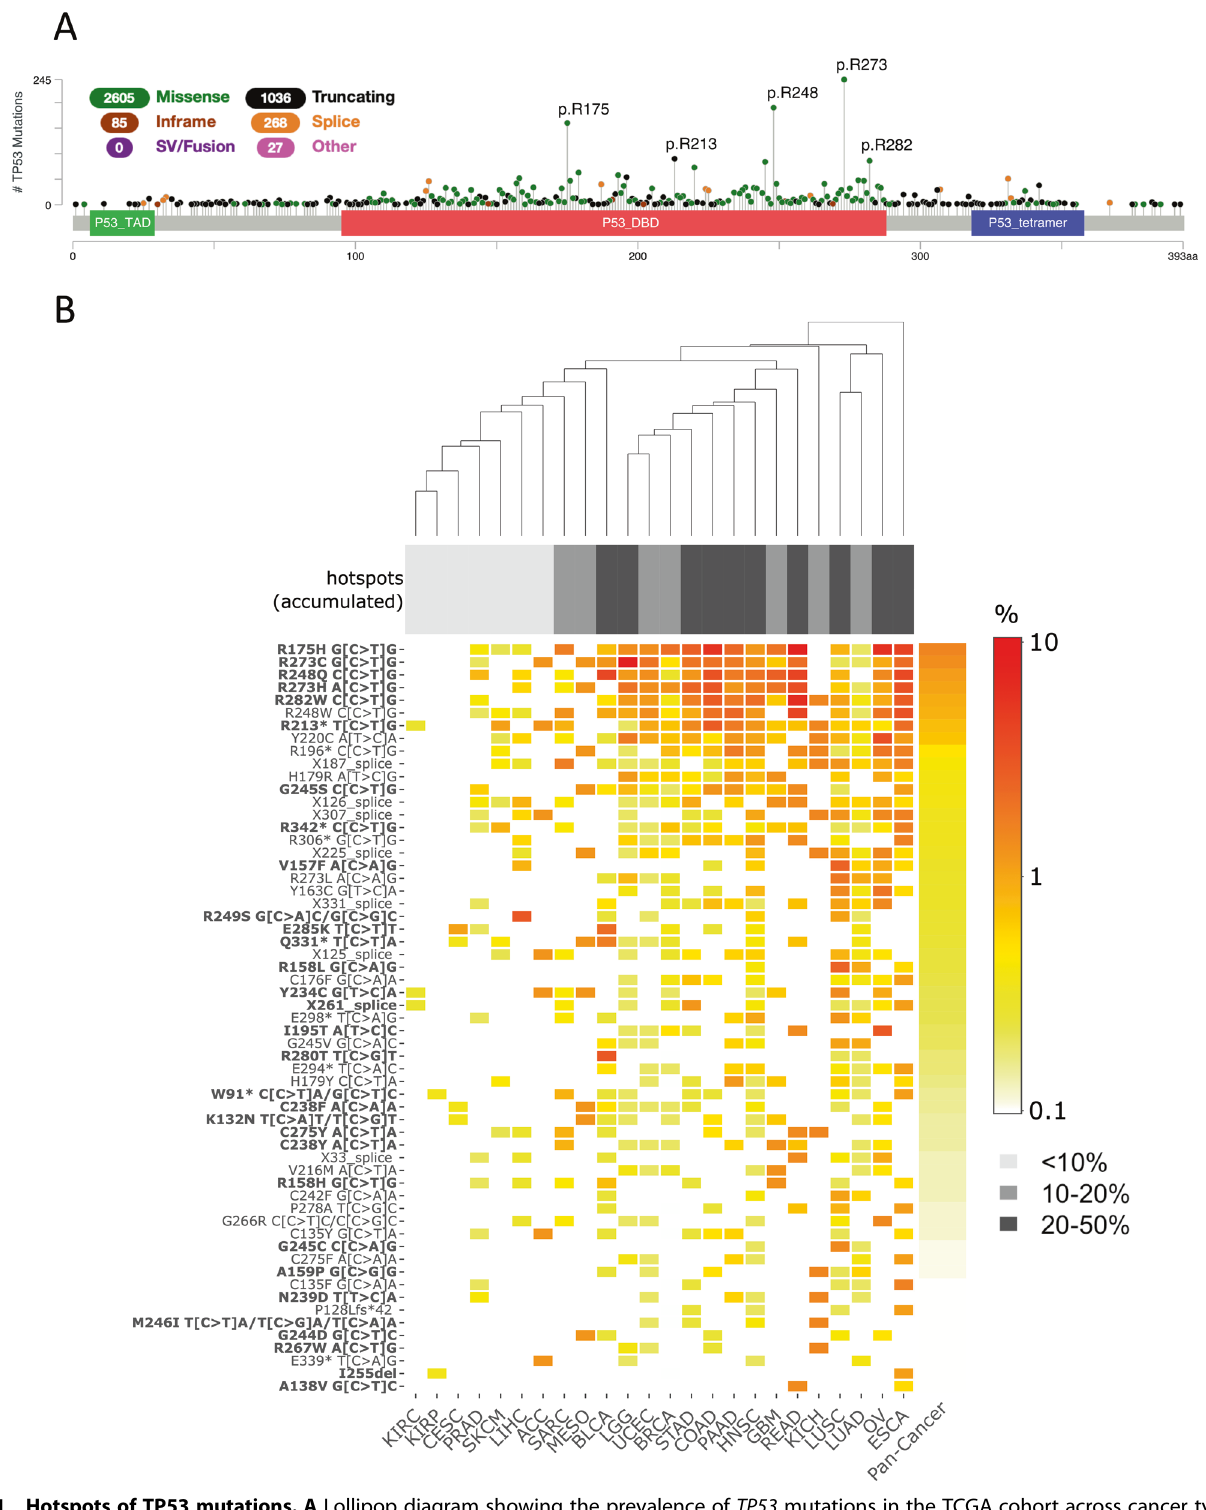
Fig. 1 Hotspots of TP53 mutations. A Lollipop diagram showing the prevalence of TP53 mutations in the TCGA cohort across cancer types. B Heatmap showing the prevalence of TP53 mutations in speci fi c cancer types of the TCGA cohort. All mutations that are prevalent with a frequency of at least 1% in at least one cancer type and are mutated in at least two tumors of at least one cancer type are included. Hotspot mutations with signi fi cantly different prevalences in different cancer types are in